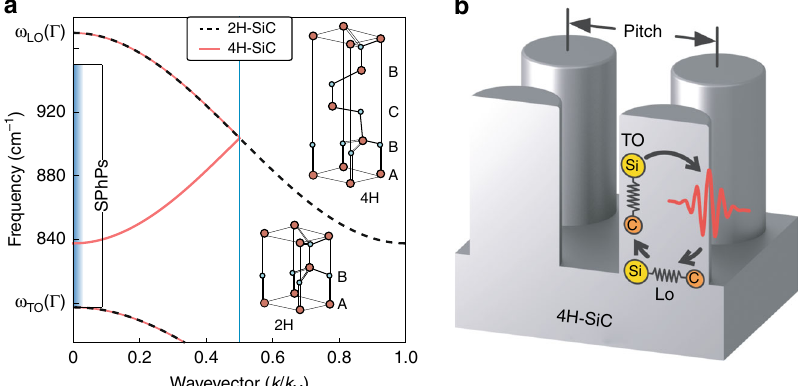
Fig. 1 Schematic of the ZLFO-SPhP hybridisation scheme. a Illustration of LO phonon dispersion parallel to the c -axis in 2H- and 4H-SiC 29 . The wavevector is normalised over the 2H-SiC Brillouin zone border k M = π / a where a is the length of the 2H-SiC unit cell along the c -axis. The shaded region illustrates the spectral range where SPhPs exist at a SiC/vacuum interface. Inset shows an illustration of the crystal structures of 2H- and 4H-SiC, the length of the 4H- unit cell is approximately twice that of the 2H- along the c -axis. b Sketch of the strong coupling between LO phonons, TO phonons, and photons, resulting in the creation of LTPPs, in a square array of 4H-SiC